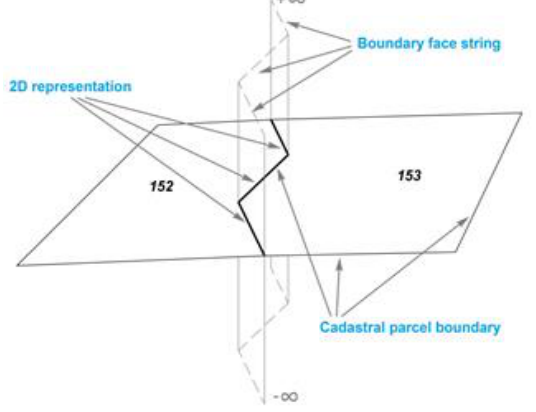
Figure 7. The concept of vertical boundary face strings